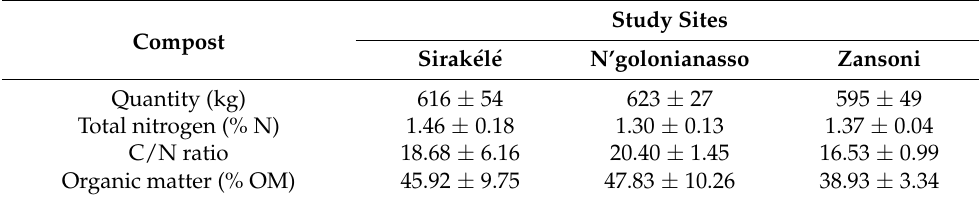
Table 3. Quantity and characteristics of compost.